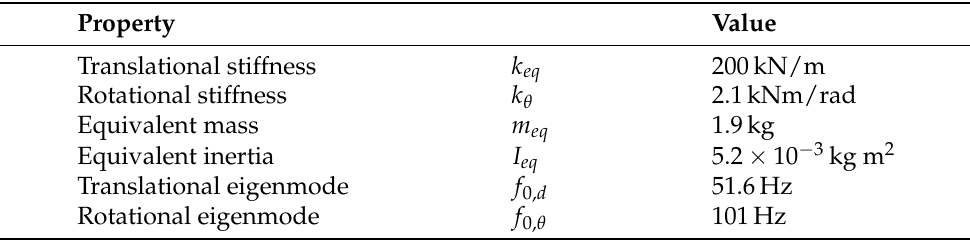
Figure 6. Schematic of the flowerbed during ( a ) translation and ( b ) totation [13]. Table 1. Flowerbed